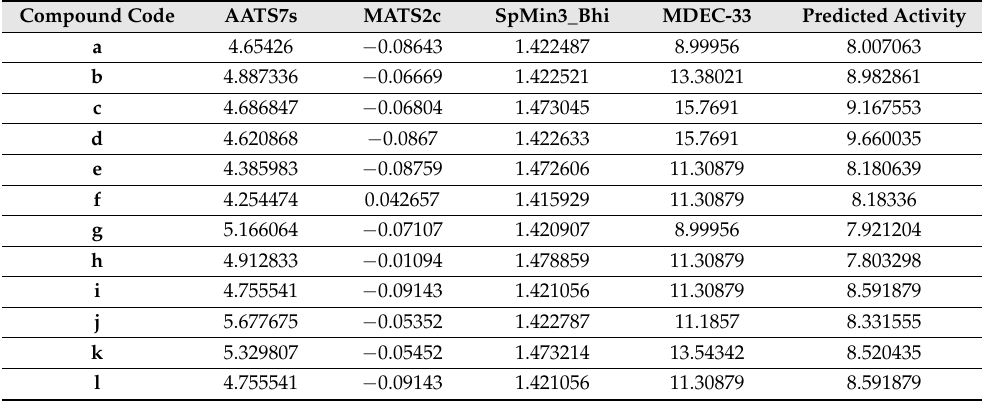
Table 5. pKi values of designed compounds predicted by the best model